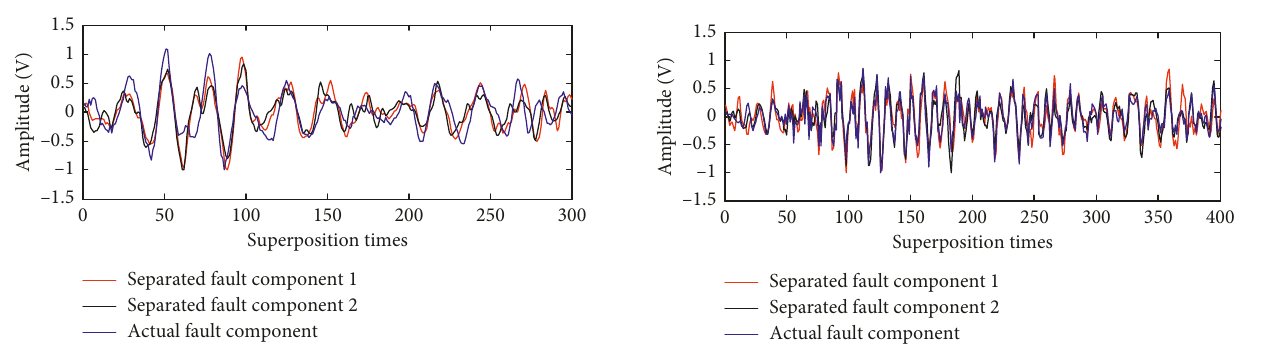
Figure 24: Separated and actual fault components of connecting rod bearing